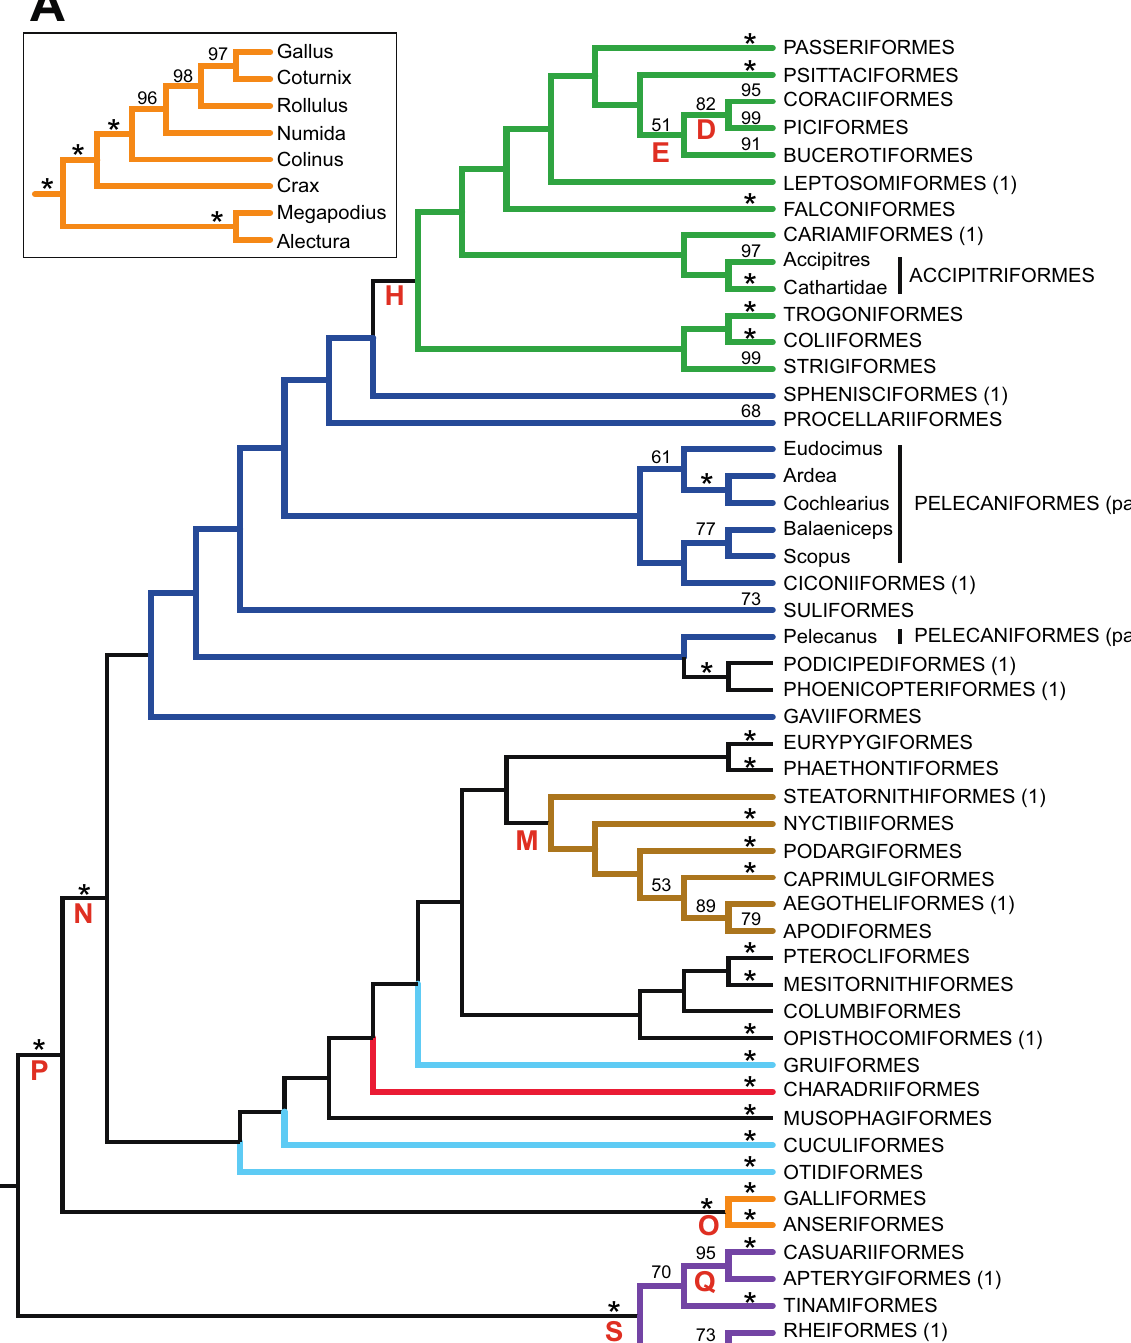
Figure 3. Estimates of avian phylogeny obtained using 12,030 gap characters obtained using ( a ) ML analyses with the (cid:38)(cid:41)(cid:49)(cid:89)(cid:14)(cid:299)(cid:3)(cid:80)(cid:82)(cid:71)(cid:72)(cid:79) and ( b ) the maximum parsimony (MP) criterion. Orders were collapsed when monophyletic to simplify the trees. Bootstrap support on terminal branches reflects the support of those orders; orders represented by a single taxon (cid:68)(cid:85)(cid:72)(cid:3) (cid:76)(cid:81)(cid:71)(cid:76)(cid:70)(cid:68)(cid:87)(cid:72)(cid:71)(cid:3) (cid:88)(cid:86)(cid:76)(cid:81)(cid:74)(cid:3) (cid:179)(cid:11)(cid:20)(cid:12)(cid:180)(cid:17)(cid:3) (cid:55)(cid:75)(cid:72)(cid:85)(cid:72)(cid:3) (cid:90)(cid:72)(cid:85)(cid:72)(cid:3) (cid:68)(cid:3) (cid:79)(cid:76)(cid:80)(cid:76)(cid:87)(cid:72)(cid:71)(cid:3) (cid:81)(cid:88)(cid:80)(cid:69)(cid:72)(cid:85)(cid:3) (cid:82)(cid:73)(cid:3) (cid:85)(cid:72)(cid:68)(cid:85)(cid:85)(cid:68)(cid:81)(cid:74)(cid:72)(cid:80)(cid:72)(cid:81)(cid:87)(cid:86)(cid:3) (cid:85)(cid:72)(cid:79)(cid:68)(cid:87)(cid:76)(cid:89)(cid:72)(cid:3) (cid:87)(cid:82)(cid:3) (cid:87)(cid:75)(cid:72)(cid:3) nucleotide topology within orders, most without bootstrap support. We highlighted the topology for the order Galliformes, because the gap topology included a clade with bootstrap support that conflicts with multiple nuclear gene regions [8,83] and morphology [84].